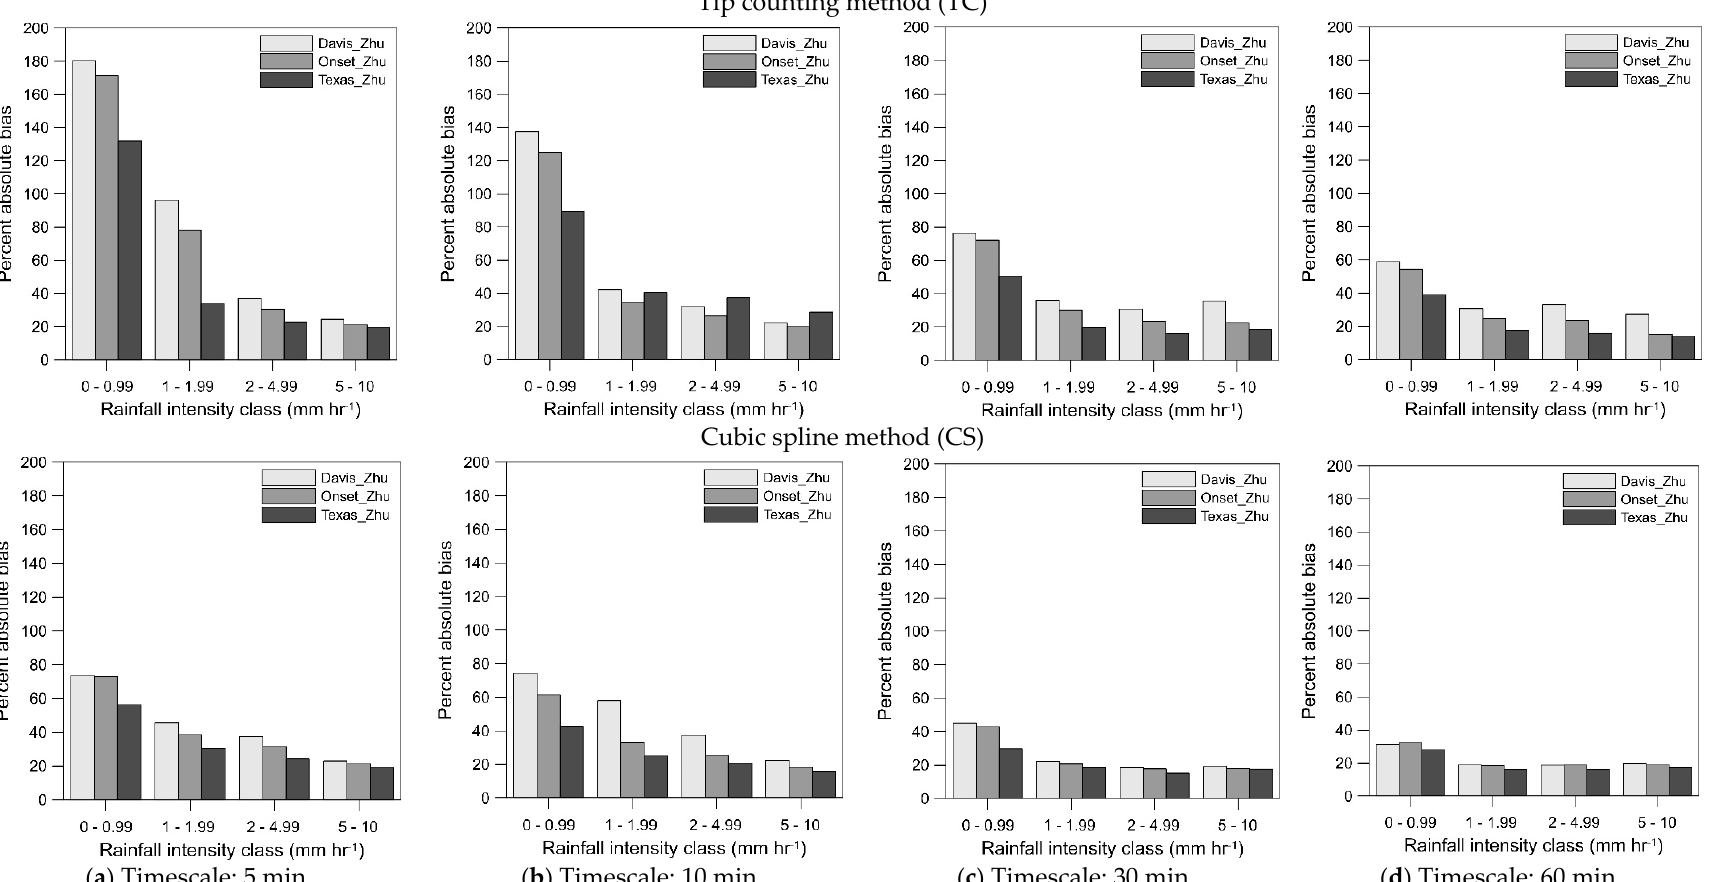
Figure 2. Percent absolute bias of the collocated tipping-bucket (TB) rain gauges Davis, Onset, and Texas with respect to the LPM sensor as a function of rainfall intensity class and timescale, respectively calculated with the tip counting (TC) ( top ) and the cubic spline (CS) method ( bottom ).